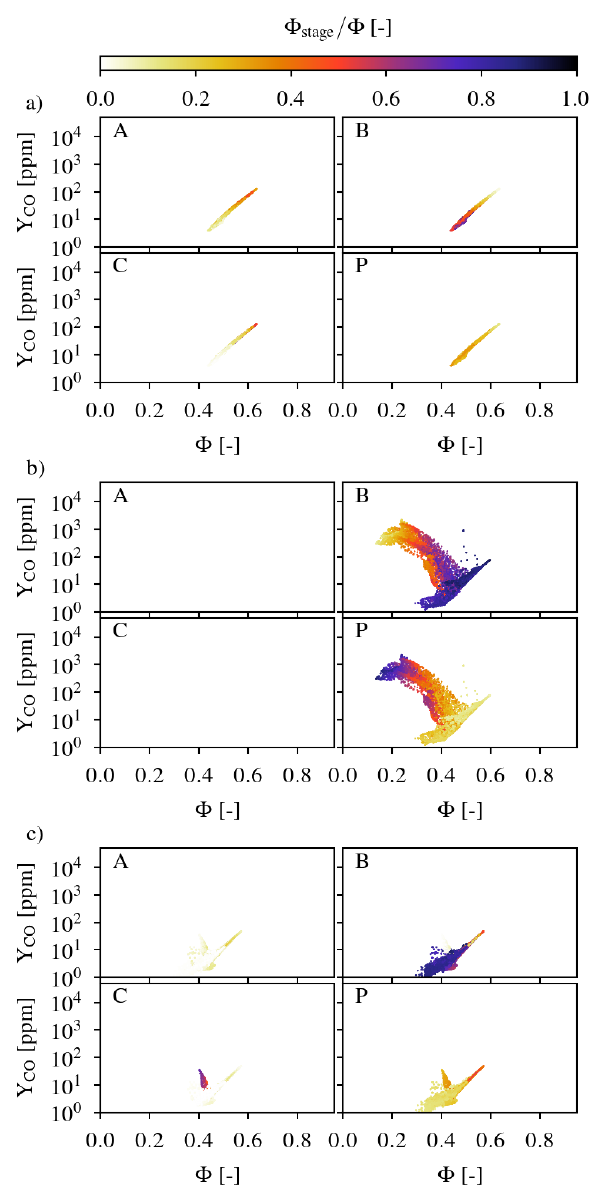
Figure 8. Carbon monoxide mass fraction Y CO over equivalence ratio Φ in dependency of the respective stage equivalence ratio Φ stage normalized by the equivalence ratio for cases ( a ) 1, ( b ) 2 and ( c )